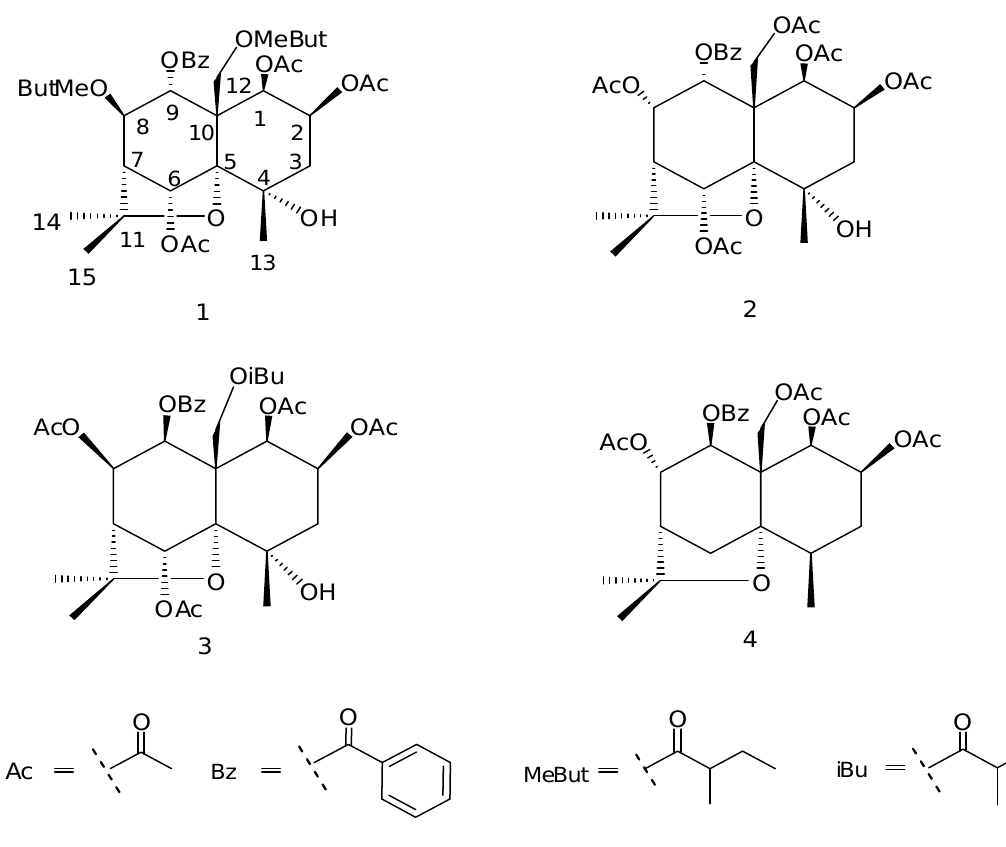
Figure 1. The structures of compounds 1-4.